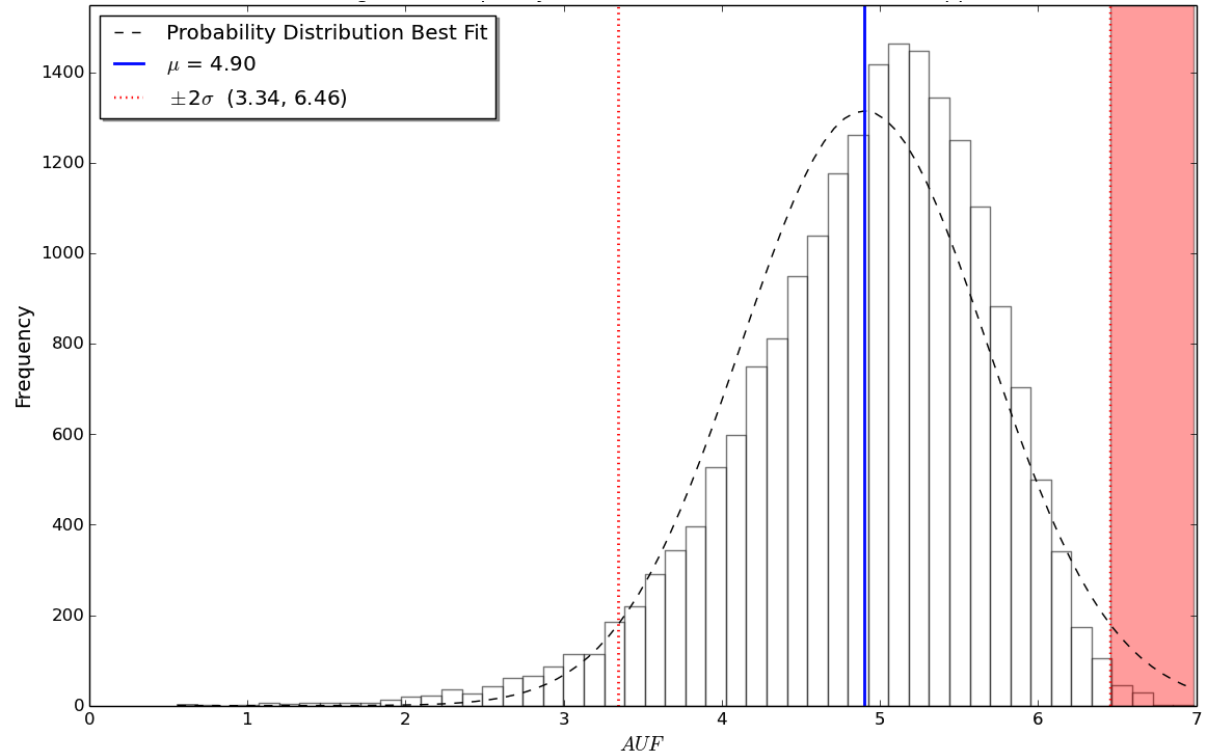
Figure 3. A histogram showing the frequency distribution of the app usage factor for the sample dataset of 20,000 simulated mobile medical apps, including mean and standard deviation for the